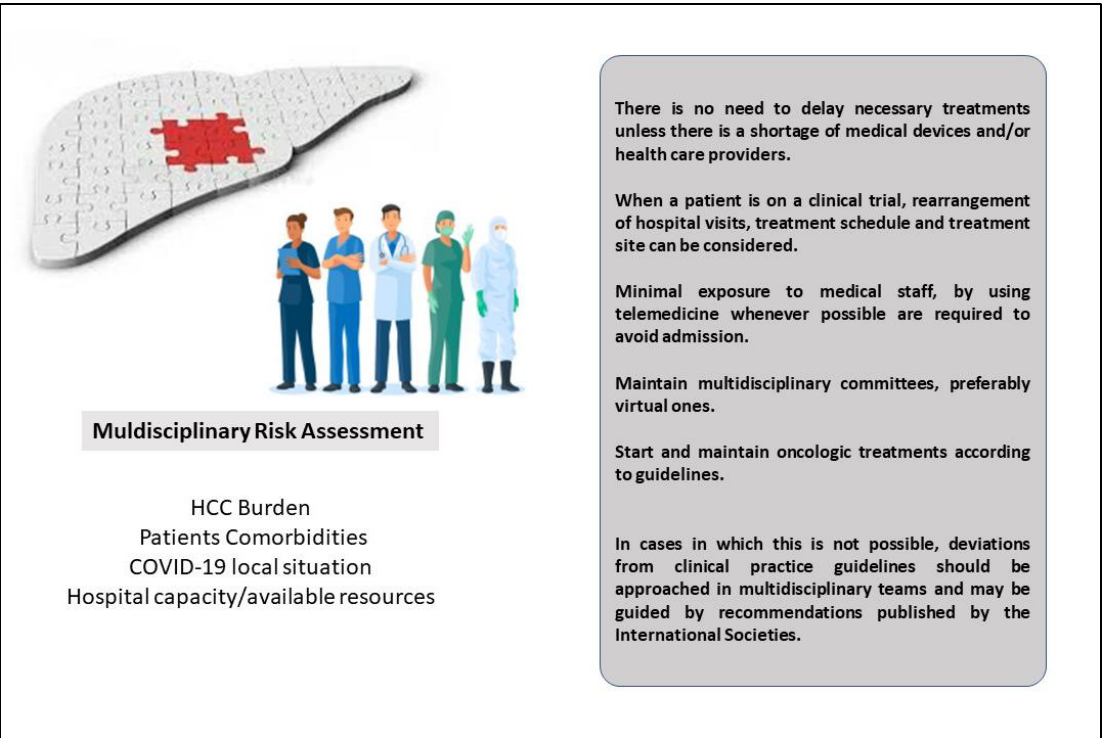
Figure 2. The role of Multidisciplinary Tumor Board during the COVID-19 pandemic for HCC pa- tients.